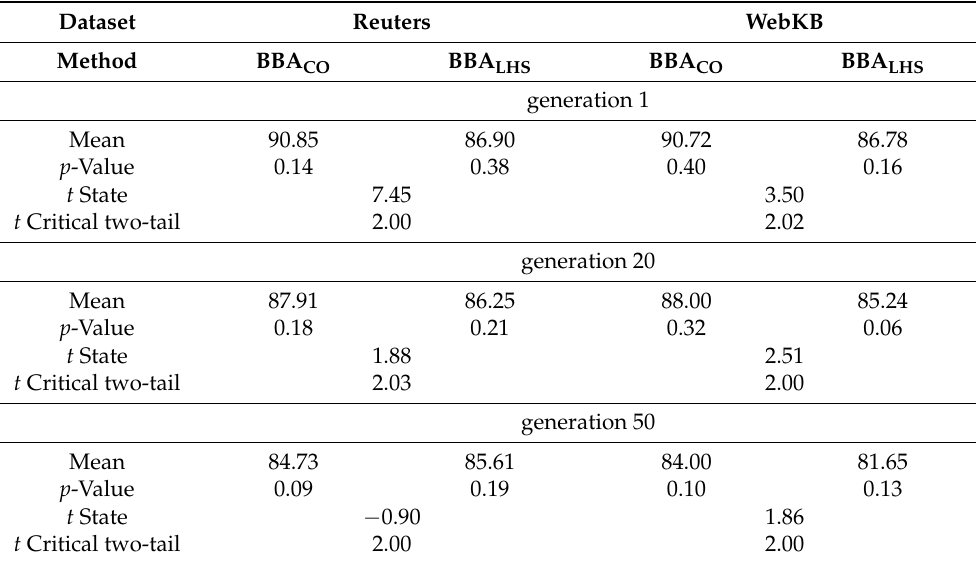
Table 7. The t -test of WRE in different generations using BBA CO and BBA LHS .